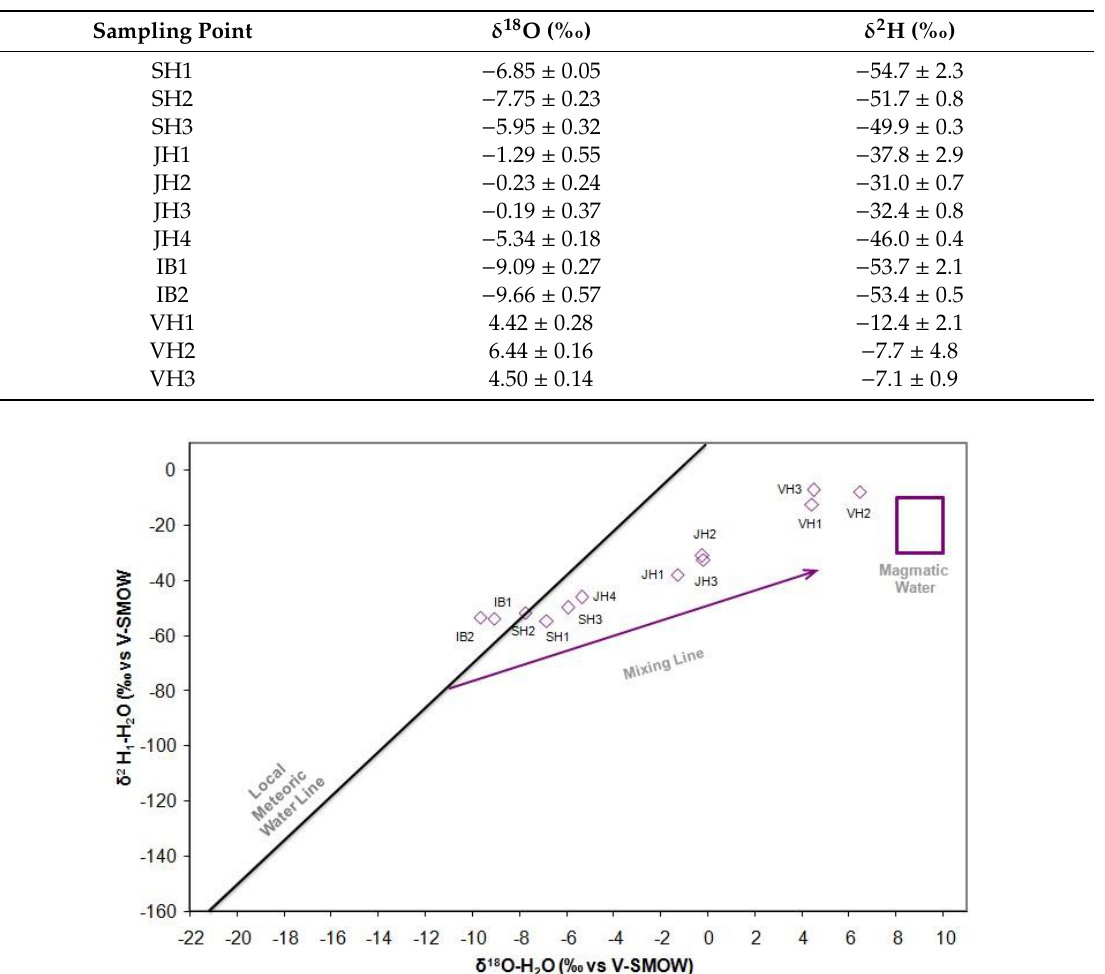
Figure 6. δ 18 O dan δ 2 H stable isotope plot. Table 10. Value of δ 1 8O and δ 2 H stable isotopes.